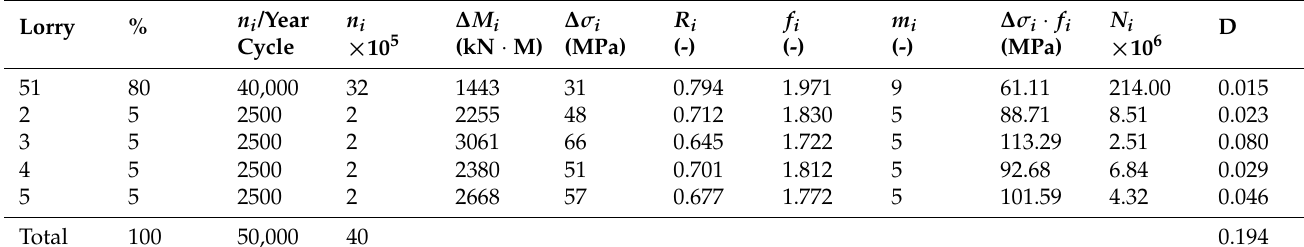
Table 4. Fatigue damage calculations using the “Local traffic”